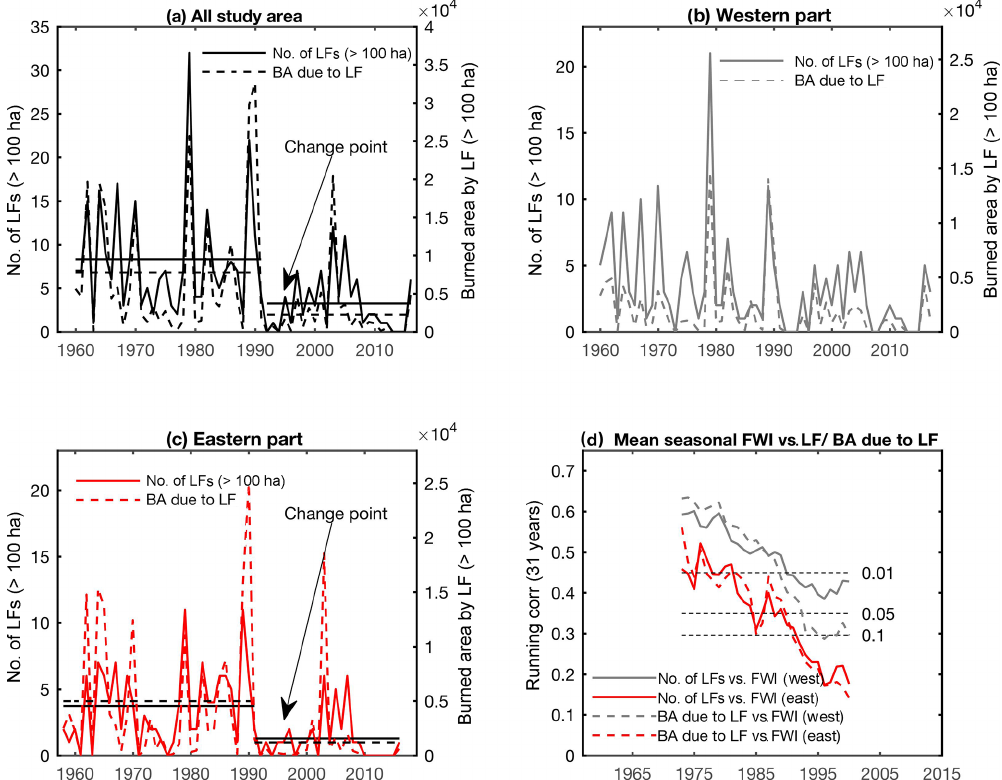
Figure 5. (a) Annual number of LFs (solid line, left axis) and area burned by LFs (dashed lines, right axis) across the region. Significant change points at the 5% confidence level according to a standard normal homogeneity test (SNHT) in both metrics are indicated. Horizontal lines indicate the overall mean observed before and after the change point. (b) Same as (a) but for the western part. (c) Same as (a) but for the eastern part. (d) Sliding correlations on 31-year windows between mean June–September FWI and annual LF frequency (solid lines) and annual burned area due to LFs (dashed lines) in the western (gray) and eastern parts (red). The horizontal dashed lines indicate different significance levels of the Pearson correlations. Correlations are indicated for the middle of the sliding